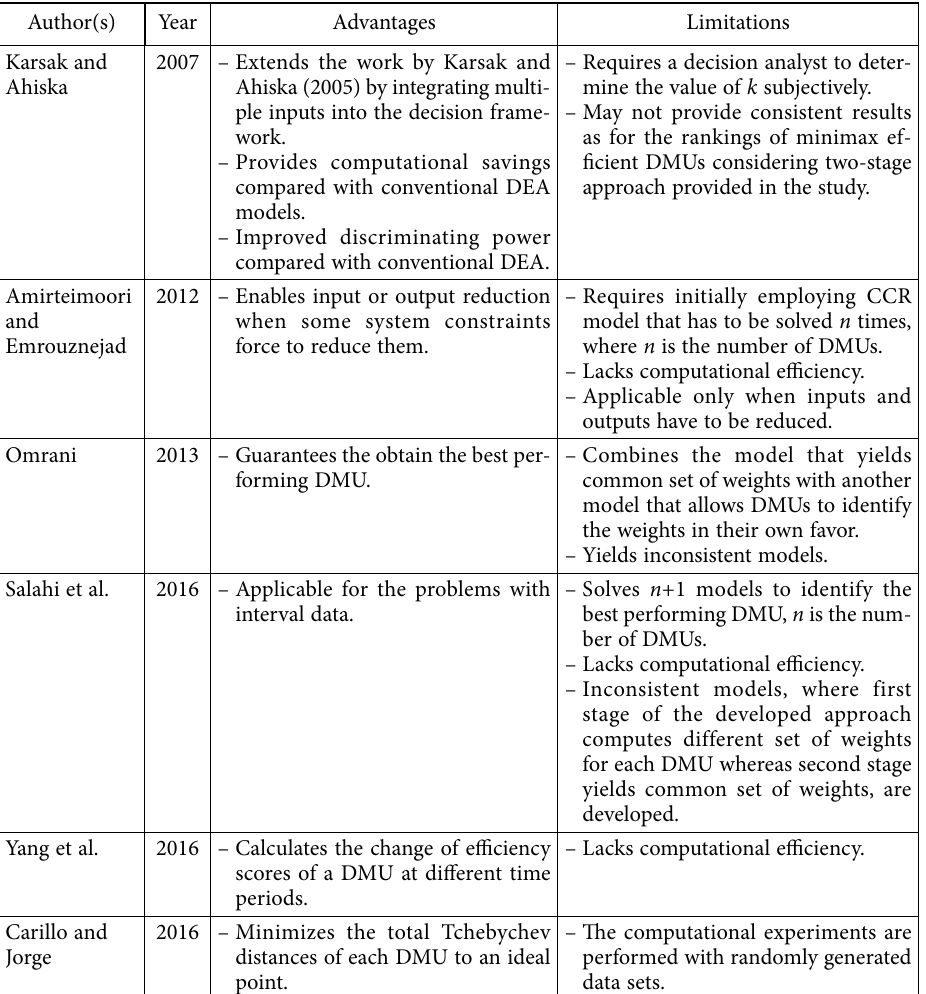
Table 2. Advantages and limitations of DEA-based models including multiples input and multiple